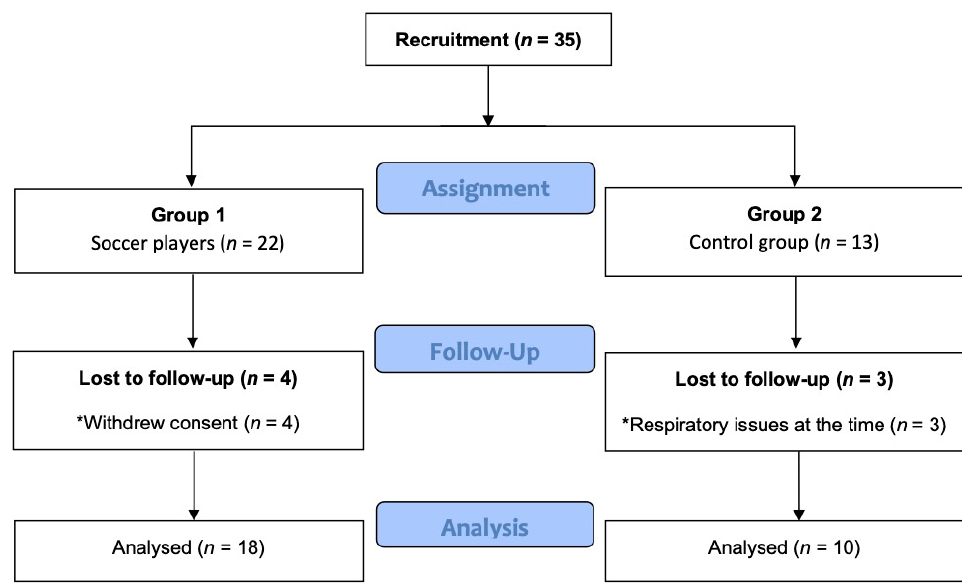
Figure 2. Flow diagram for recruitment process of the participants.